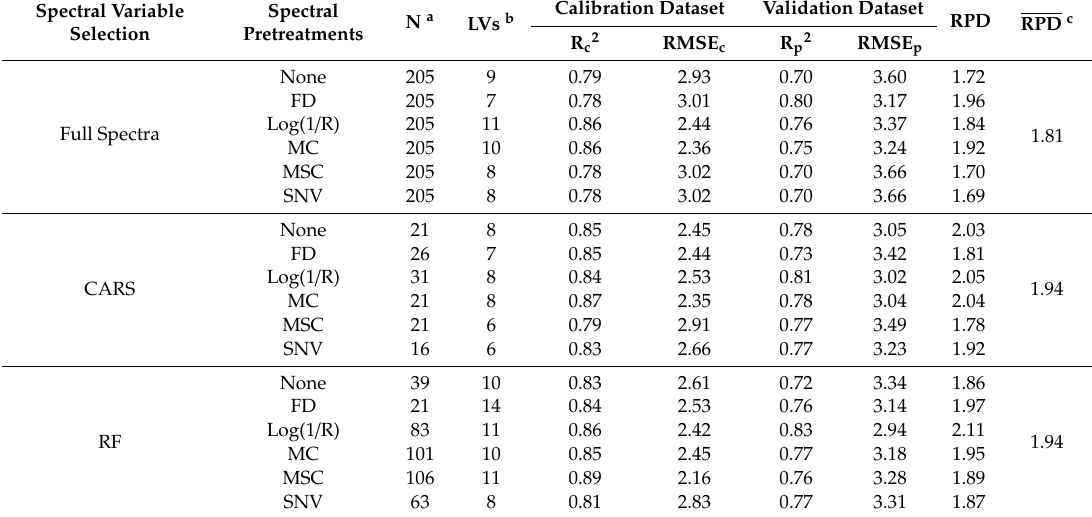
Table 2. Accuracies of soil organic carbon (SOC) estimation using full-spectrum-based partial least